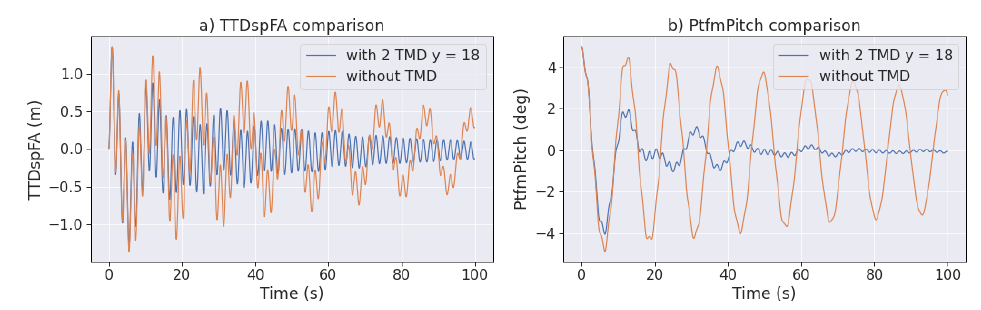
Figure 14. Comparison of TTDspFA ( a ) and PtfPitch ( b ) without TMD (orange) and with two TMDs located in the side-side axis at 18 m from the center (blue).